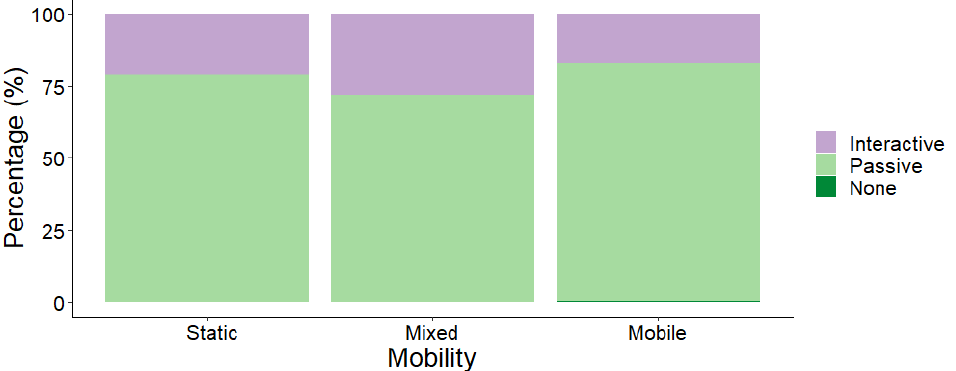
Figure 25. Deployment distribution between node mobility and deployment interactivity.